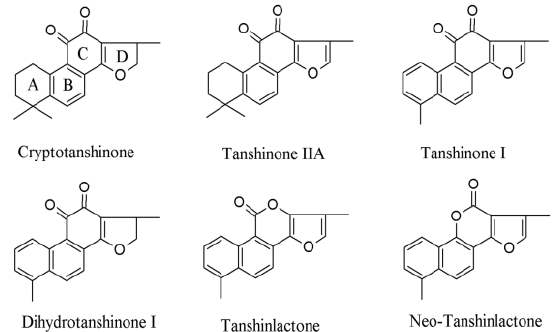
Figure 1. Chemical structures of major tanshinones and